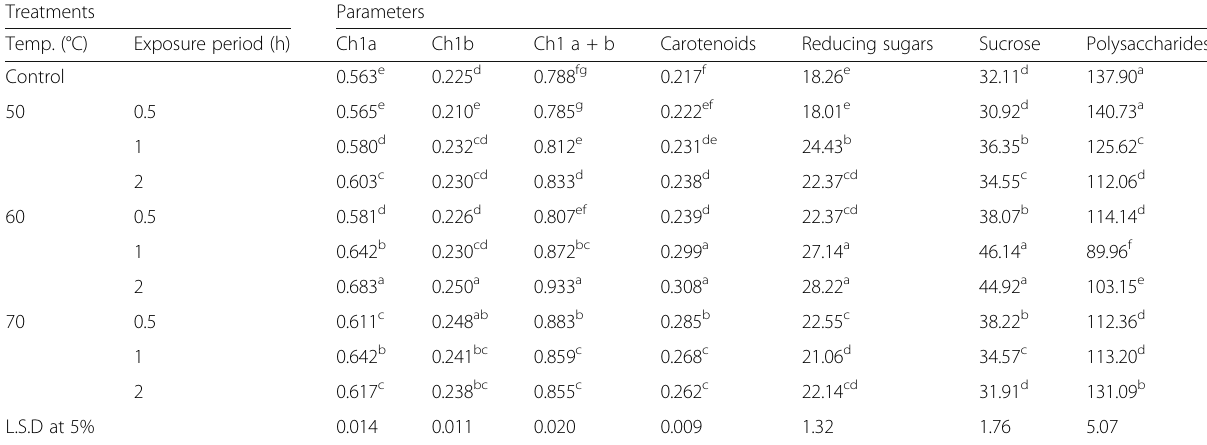
Table 5 Effect of seed hardening on photosynthetic pigments (mg/g fresh weight of leaves) and carbohydrate content of shoots (mg/glucose/g dry wt.) Temp. (°C)